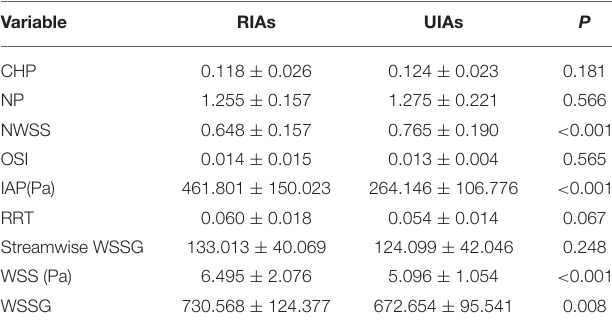
TABLE 3 | Result of hemodynamic parameters between RIAs and